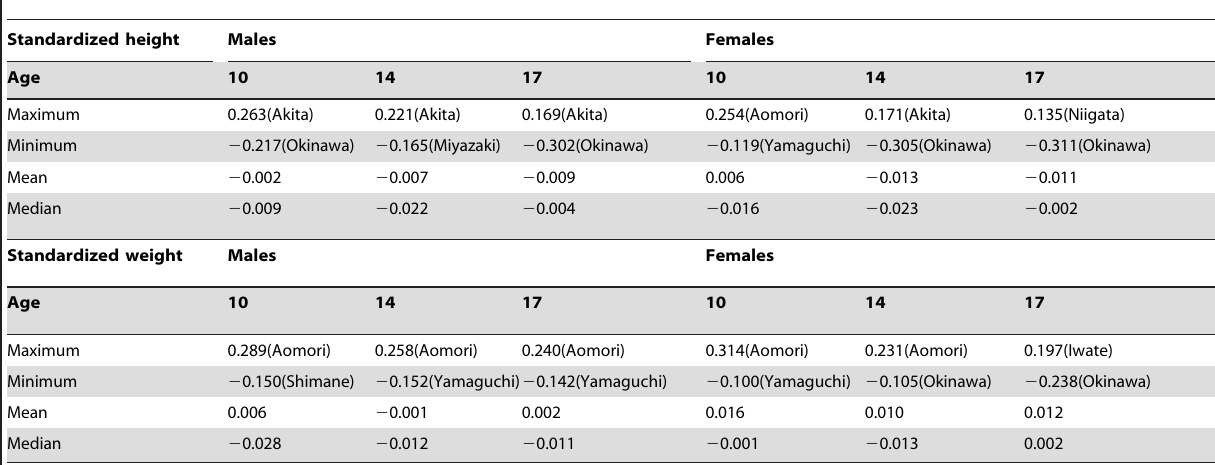
Table 1. Basic statistics for standardized height and weight.